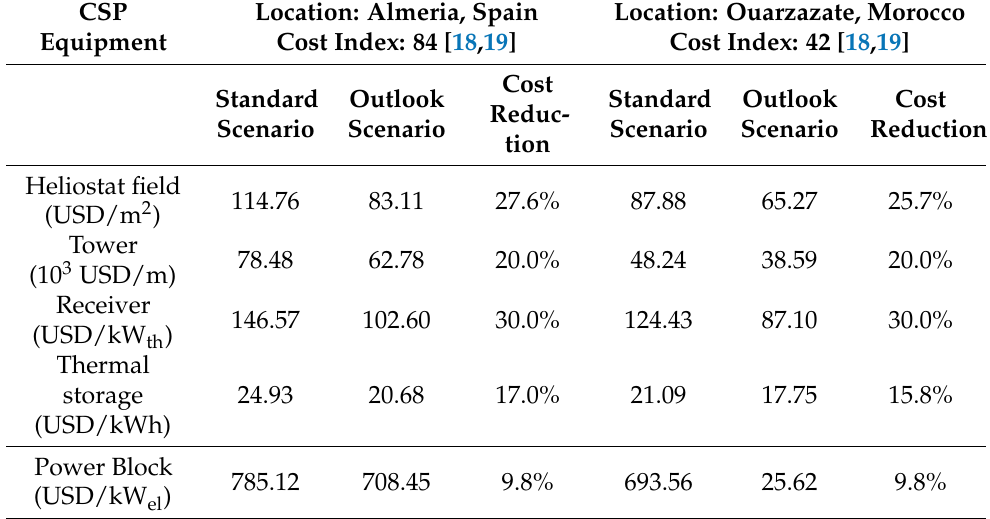
Table 7. CSP equipment costs for the standard and the cost reduction outlook scenario for the location Almeria in Spain and Ouarzazate in Morocco.